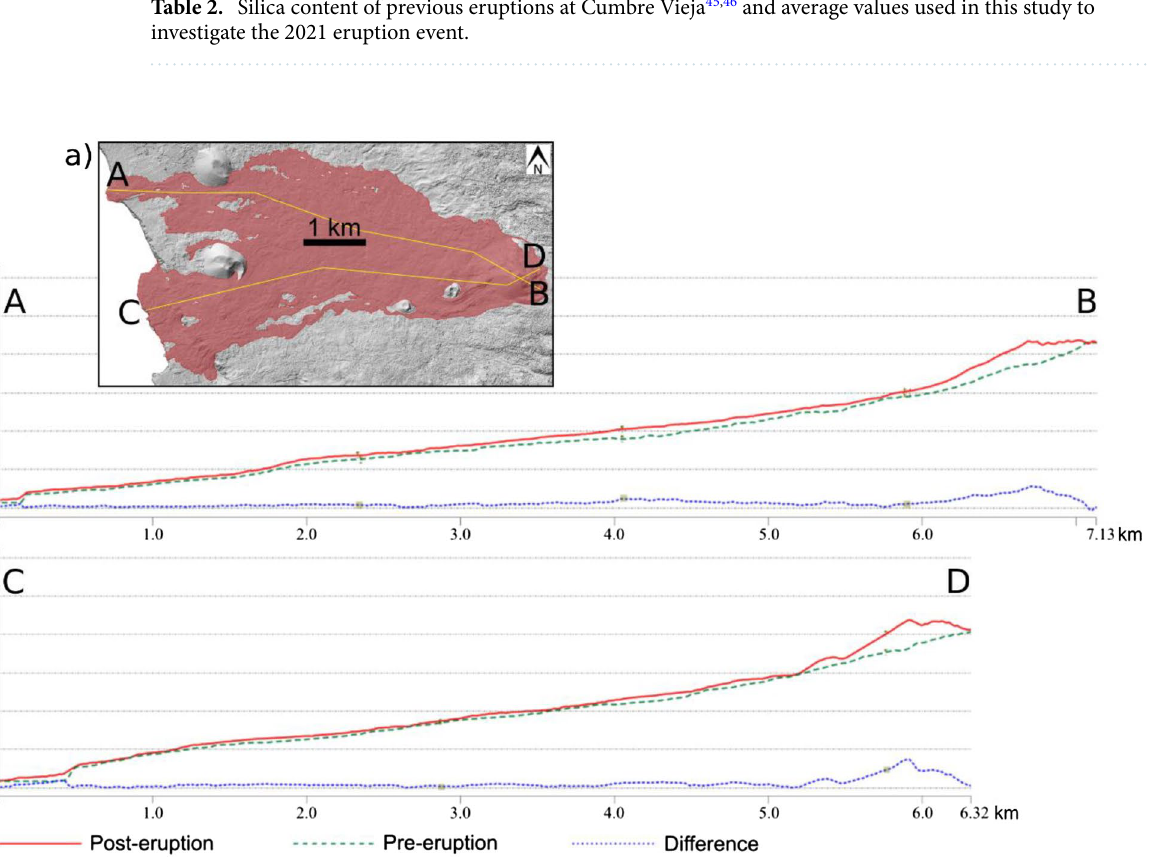
Figure 3. Hillshade visualization of the Pléiades DSM with the location of the profiles A-B and C-D on the final lava flow area ( a ). Profiles of the pre-eruptive and post-eruptive topography as well as the lava flow thickness derived by comparison of the Pléiades DSM (December 31, 2021) and the pre-eruptive LiDAR DSM ( b ). Map created using QGIS 3.28 https:// www. qgis.